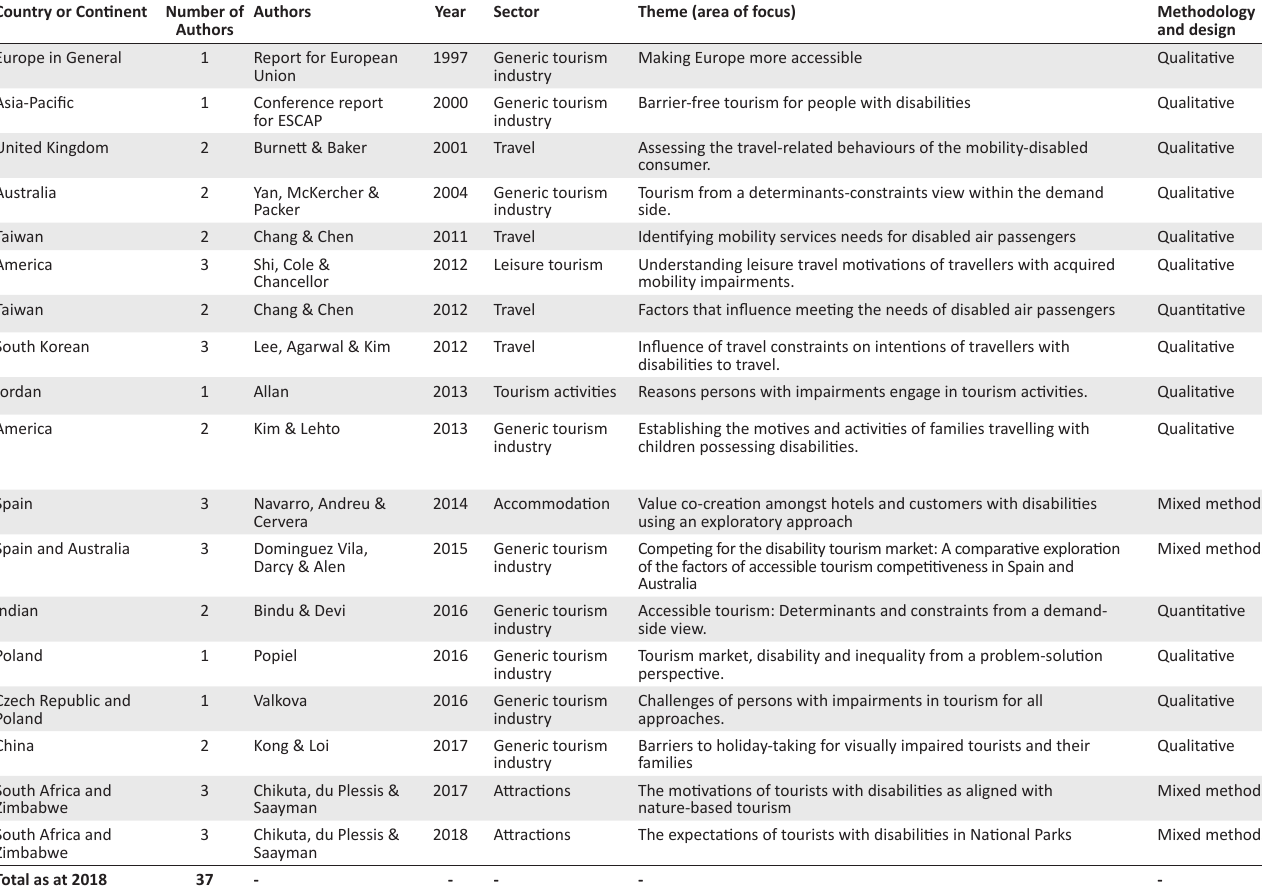
TABLE 4: Research on tourism demand, impairments and disability and disabled tourists (in sequential order of years, from 1997 to 2018). Country or Continent Number of Authors